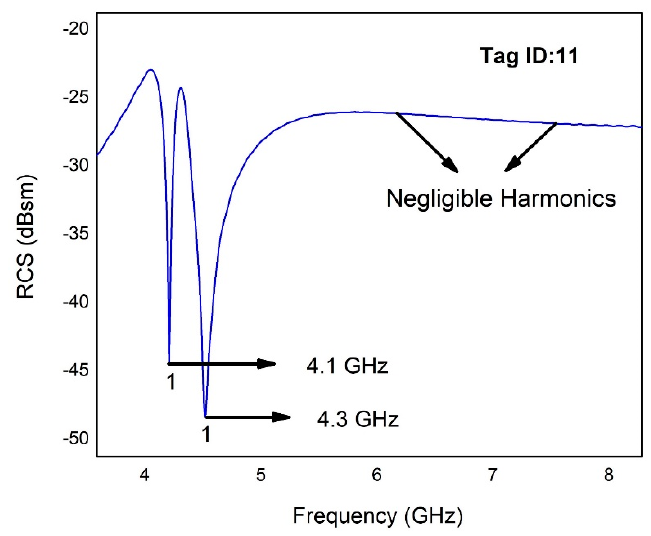
Figure 3. Dual resonant element geometric design.